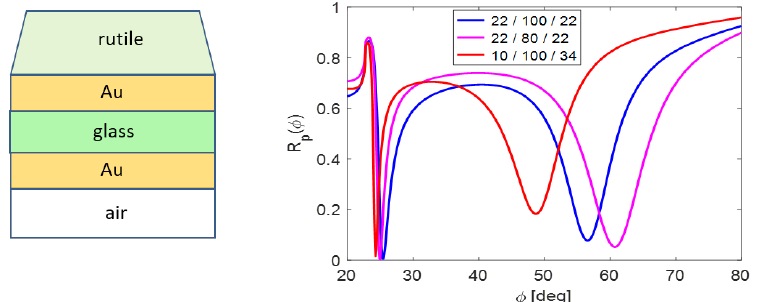
Figure 5. Plasmonic resonance states in the MIM structure with thin Au films: the LR SPR minima on the left ( φ ≈ 25 ◦ ); and the SR SPR dips on the right. The nanometer values of layer thicknesses in the legend are ordered from the closest to the prism to the air substrate.